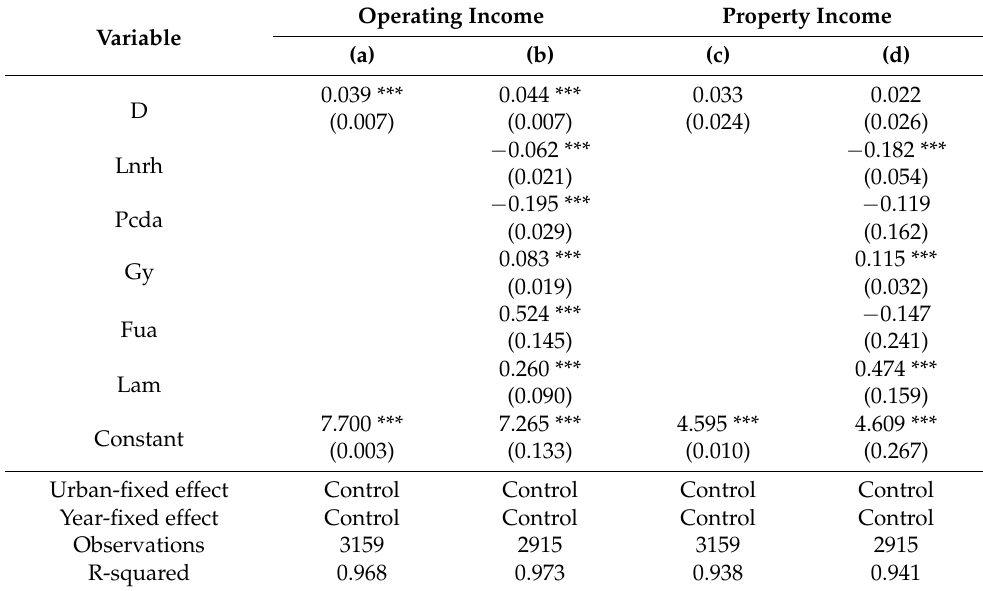
Table 3. Robustness